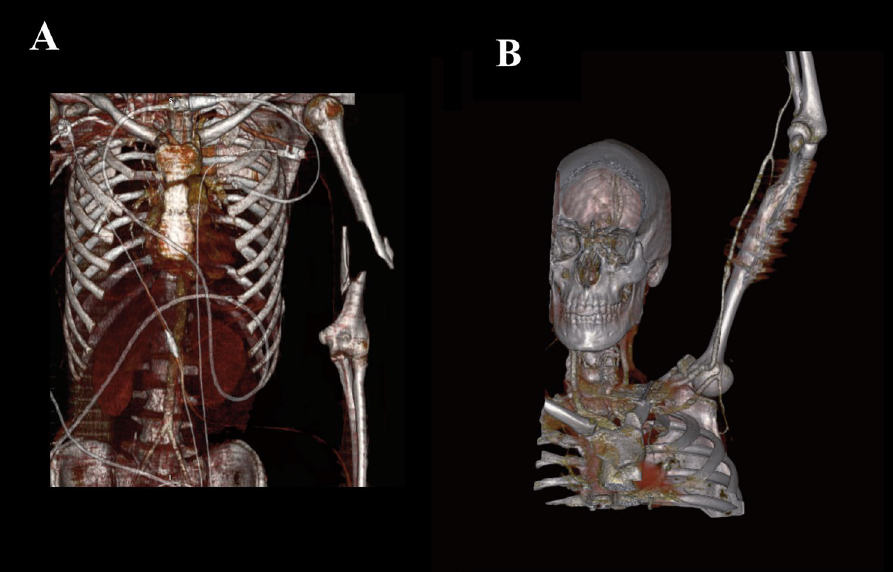
Figure 1. Pre-, and postoperative 3D reconstruction of a patient with a dissection of the left axillary and brachial artery. ( A ) Preoperative imaging of the patient. ( B ) Postoperative imaging 11 years after a GSV brachial-brachial bypass.